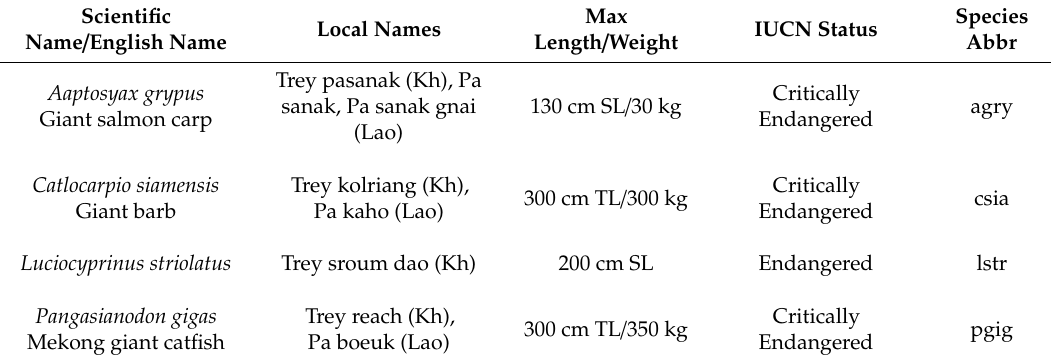
Table 1. Mekong megafish species investigated in this study. Information was obtained from the FishBase (www.fishbase.org) and IUCN (www.iucnredlist.org) databases. Some local names were provided by local collaborators. For local names, “Kh” = Khmer language name; “Lao” = Lao language name. Maximum length abbreviations: “SL” = Standard Length; “TL” = Total Length; “WD” = Width. The “Species Abbr” column shows the species name abbreviations used throughout the